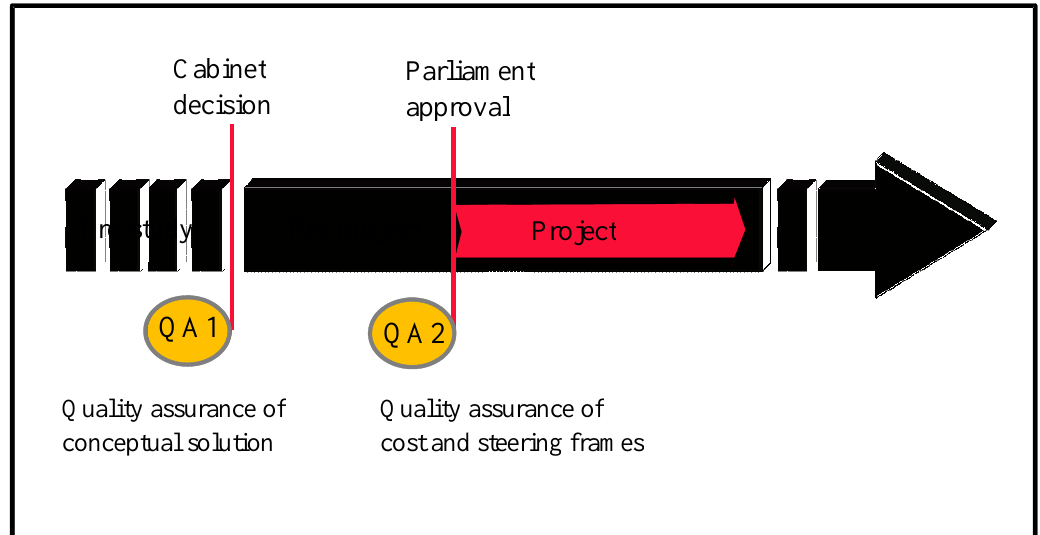
Figure 2. The Norwegian Quality Assurance regime for major public investment